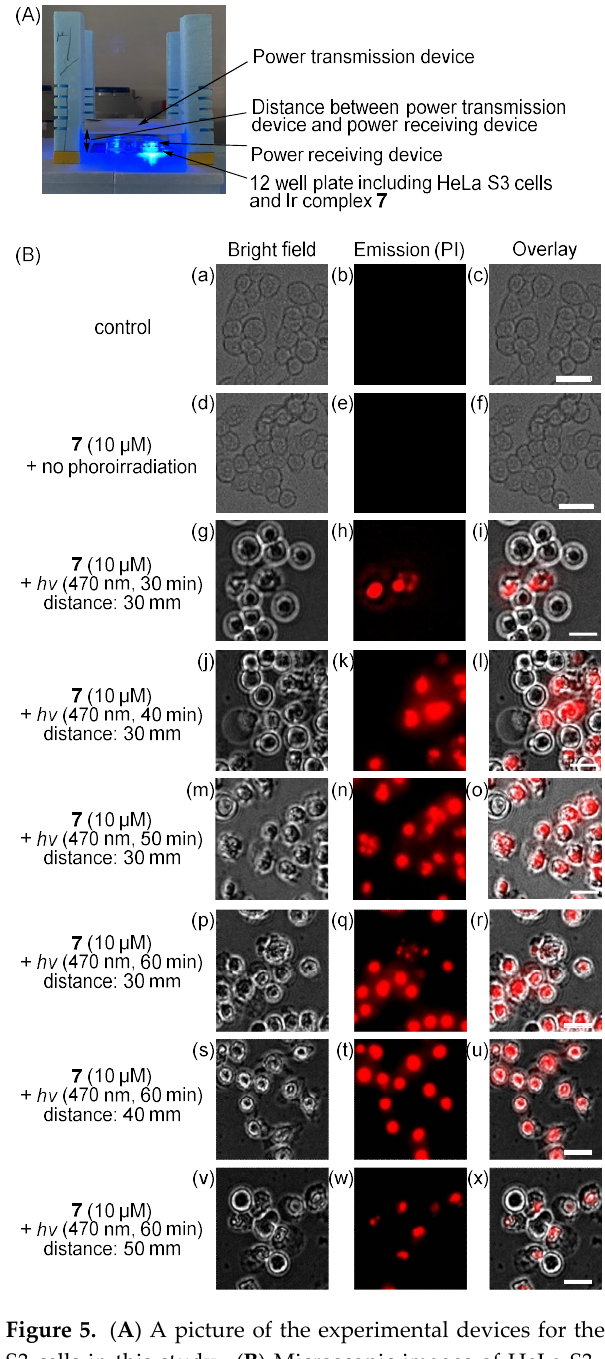
Figure 5. ( A ) A picture of the experimental devices for the WPT-based photoirradiation of HeLa S3 cells in this study. ( B ) Microscopic images of HeLa S3 cells ( a – c ) in control, ( d – f ) in the presence of 7 (10 µM) without photoirradiation, and ( g – x ) in the presence of 7 with photoirradiation at 470 nm for 30–60 min for different distances between the PT and PR at 10 V. ( a , d , g , j , m , p , s , v ) Bright field images of HeLa S3 cells, ( b , e , h , k , n , q , s , w ) emission images of PI (excitation at 540 nm and emission at 605 nm), ( c ) overlay image of ( a , b ), ( f ) overlay image of ( d , e ), ( i ) overlay image of ( g , h ), ( l ) overlay image of ( j , k ), ( o ) overlay image of ( m , n ), ( r ) overlay image of ( p , q ), ( u ) overlay image of ( s , t ), and ( x ) overlay image of ( v , w ). The scale bar (white) is 20 µm. The effect of the photoirradiation time (irradiation at 470 nm) on cell death in HeLa S3 cells was examined. As shown in Figure 6, the efficiency of cell death in HeLa S3 cells increases with decreasing distance between the PT and PR (65%, 26%, and 4% for dis- tances of 30, 40, and 50 mm, respectively, after the photoirradiation for 50 min) and with